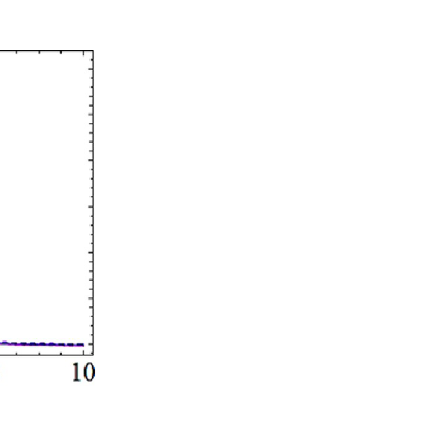
Fig 3. Velocity profiles for different values of CuO volume